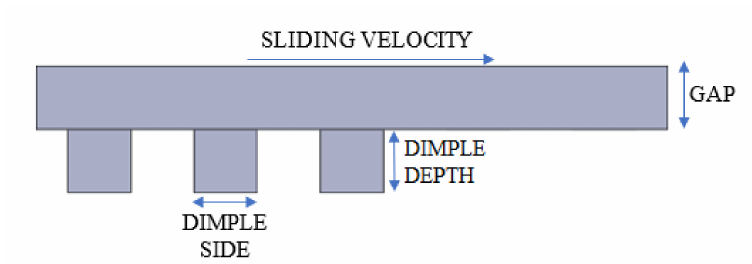
Figure 17. Graphic representation of the partial texturing configuration with the main geometric features